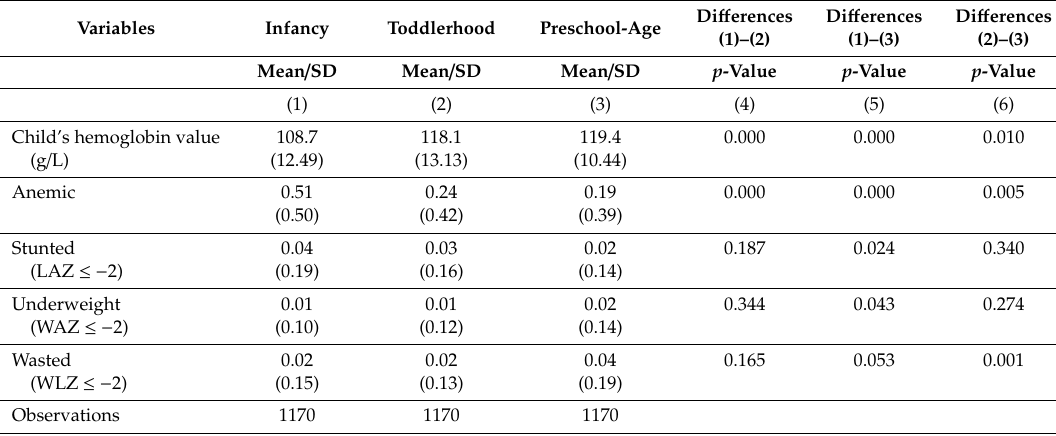
Table 2. Hb concentration, anemia and physical